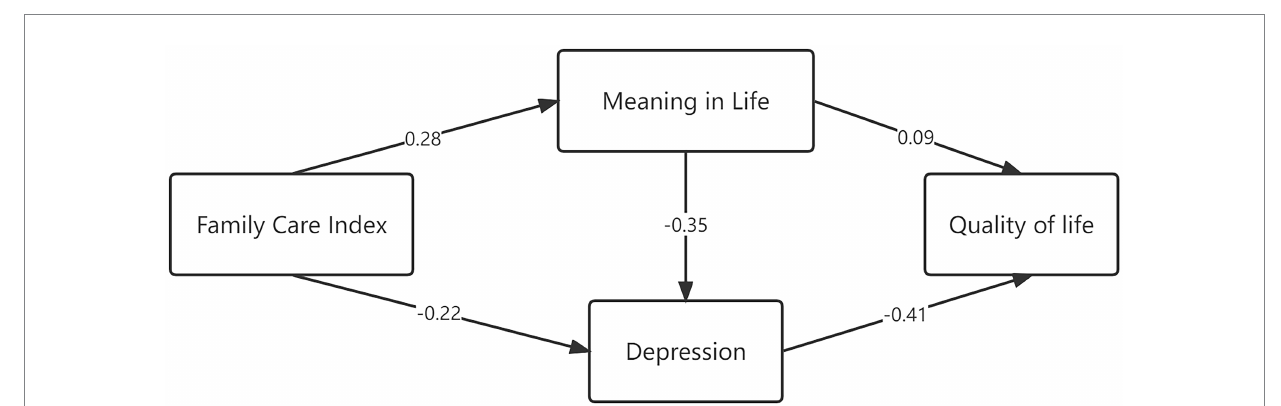
FIGURE 1 Pathways among meaning in life, family care index, depression, and quality of life.